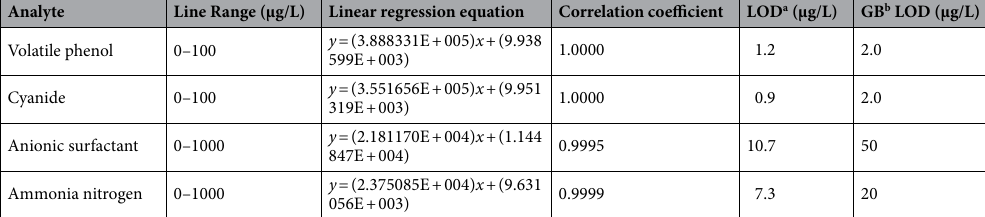
Table 2. Standard curve, correlation coefficient and detection limit of 4 kinds of analytes. a LOD: Limits of detection. b GB: National standard code for Chinese characters.